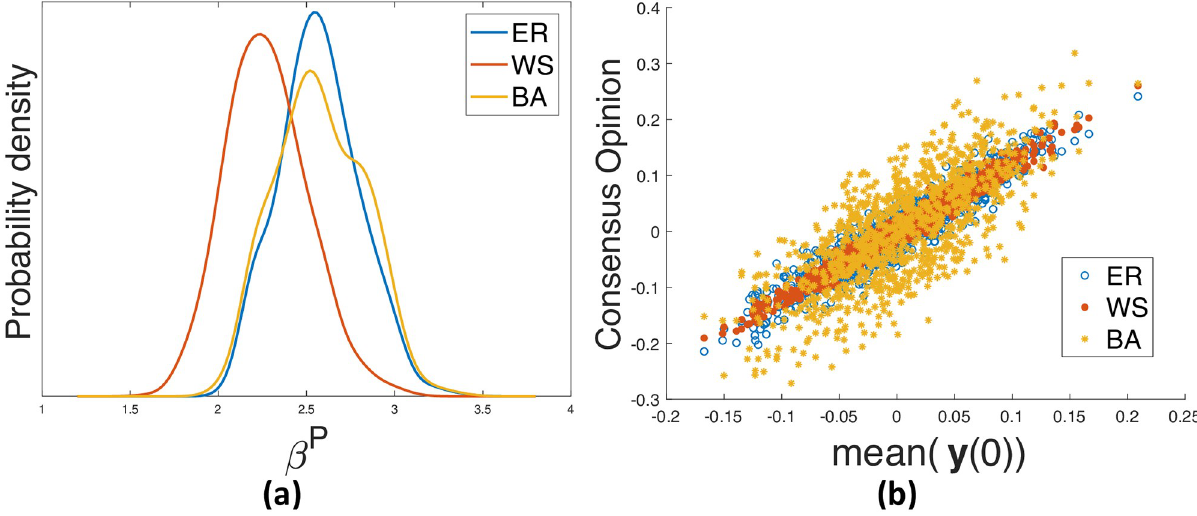
Fig 6. Based on one ER model ( n = 100, ρ = 0.0606), one WS model ( n = 100, K = 6, σ = 0.2), and one BA model ( n = 100, M 0 = 4, M = 3). (a) distribution of β P for 1,000 random opinion vectors; (b) for 1,000 opinion vectors, the relation between the consensus value and the mean y (0) when β =